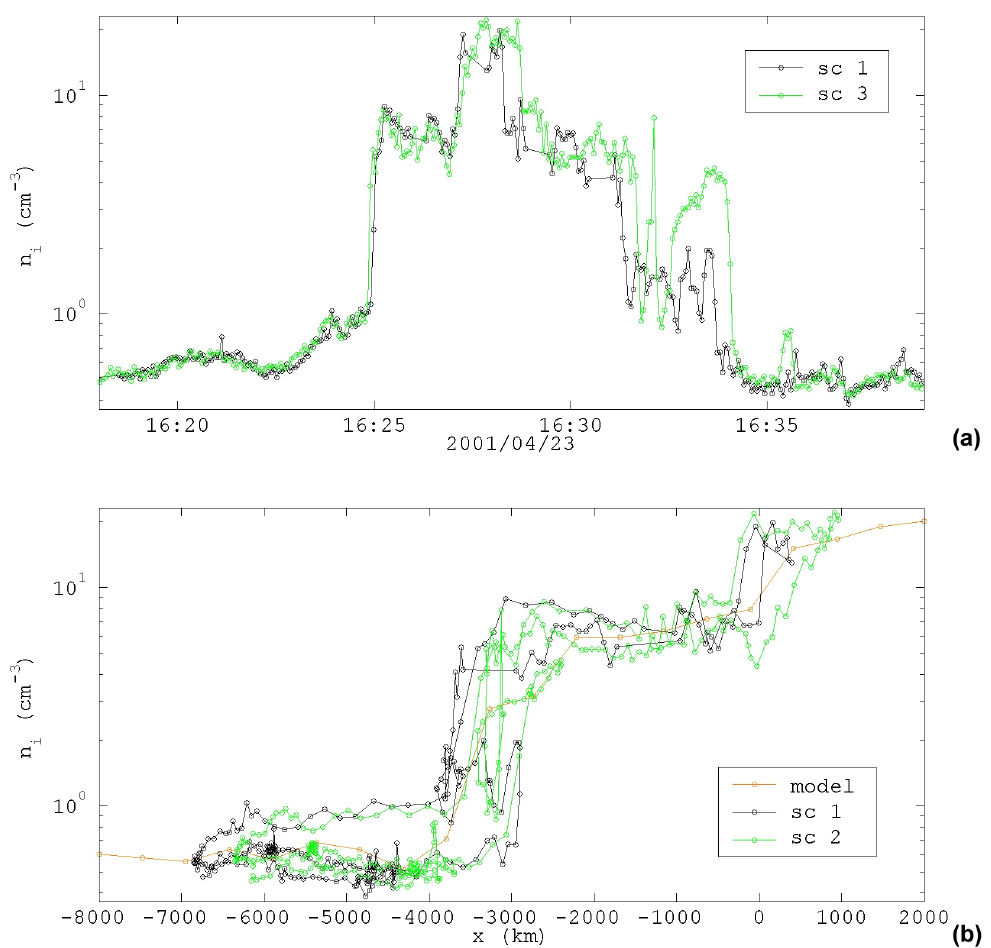
Fig. 2. Analysis of the transient event on 23 April 2001. ( a ) . Time profiles of ion density n i (t) from CIS/HIA. ( b ) Spatial profiles n i (x sc (t) − ξ (t)) and an empirical